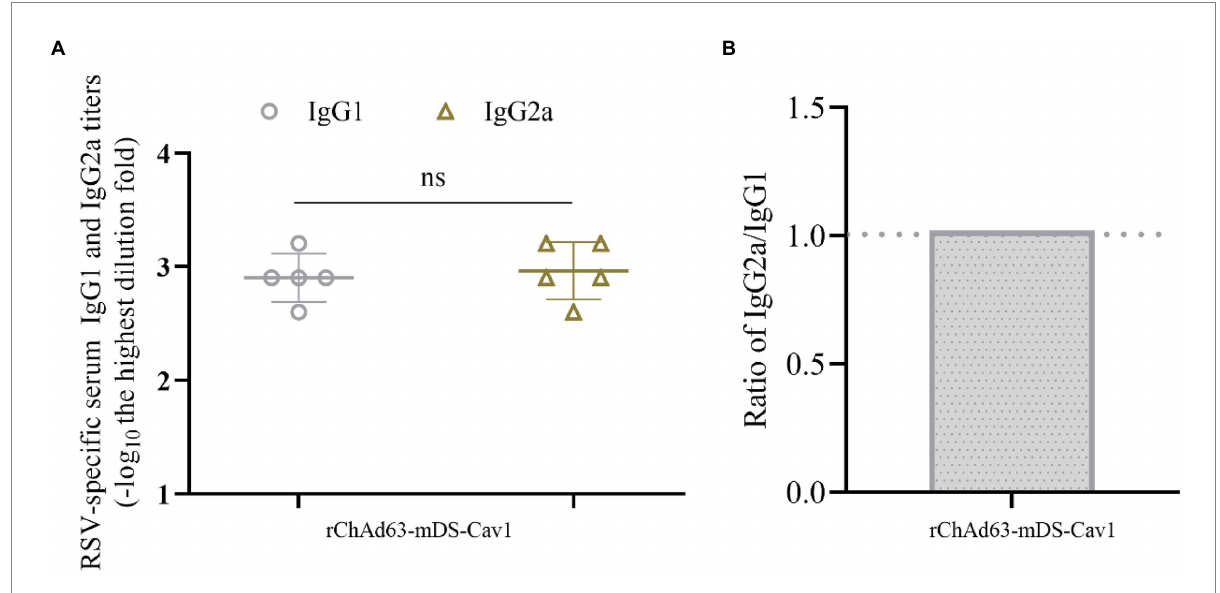
FIGURE 4 Serum anti-RSV isotype response following immunization with rChAd63-mDS-Cav1 in BALB/c mice. BALB/c mice ( n = 5) were immunized intranasally with rChAd63-mDS-Cav1, and the serum anti-RSV isotype responses were detected by ELISA. (A) The titers of anti-RSV IgG1 and IgG2a. The antibody titers were defined as the reciprocal of the highest serum dilution that gave an OD450 value of 2.1-fold over naïve sera. (B) The ratio of IgG2a and IgG1 titers. Data were shown as mean ± SD, ns: no statistical